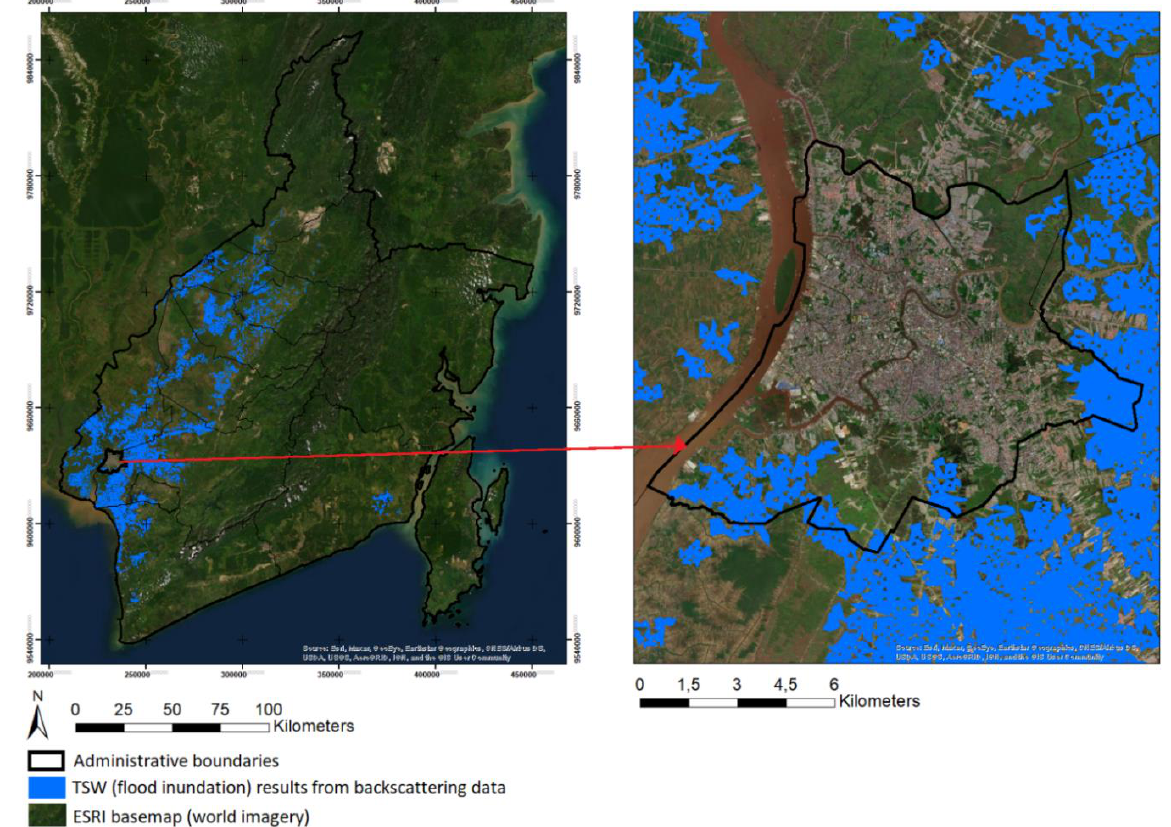
Figure 3 . Temporary Surface Water (TSW) Result from Backscattering Data.